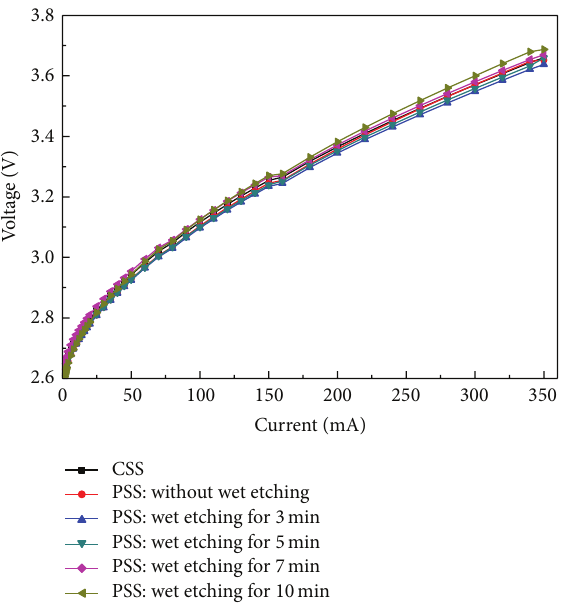
Figure 6: Light output power as a function of injection current of the InGaN LEDs prepared on the CSS and various cone-shaped PSSs subjected to wet etching from 0 to